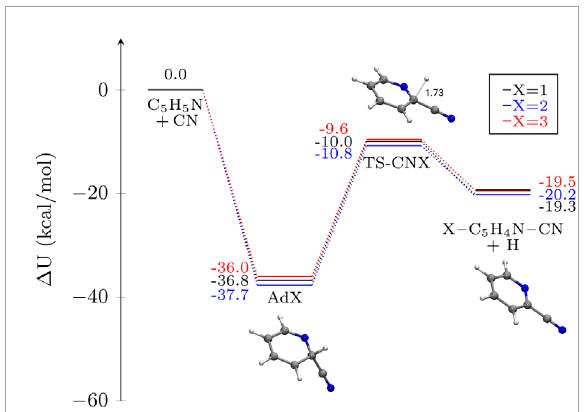
FIGURE 2 Potential energy profiles for the addition of CN to pyridine in different carbon atomic positions. The depicted magnitude is Δ U (electronic energy + ZPVE) in kcal mol −1 . Molecular structures of the stationary points on the different PES other than pyridine are shown for X = 1 as an example. Distances are given in